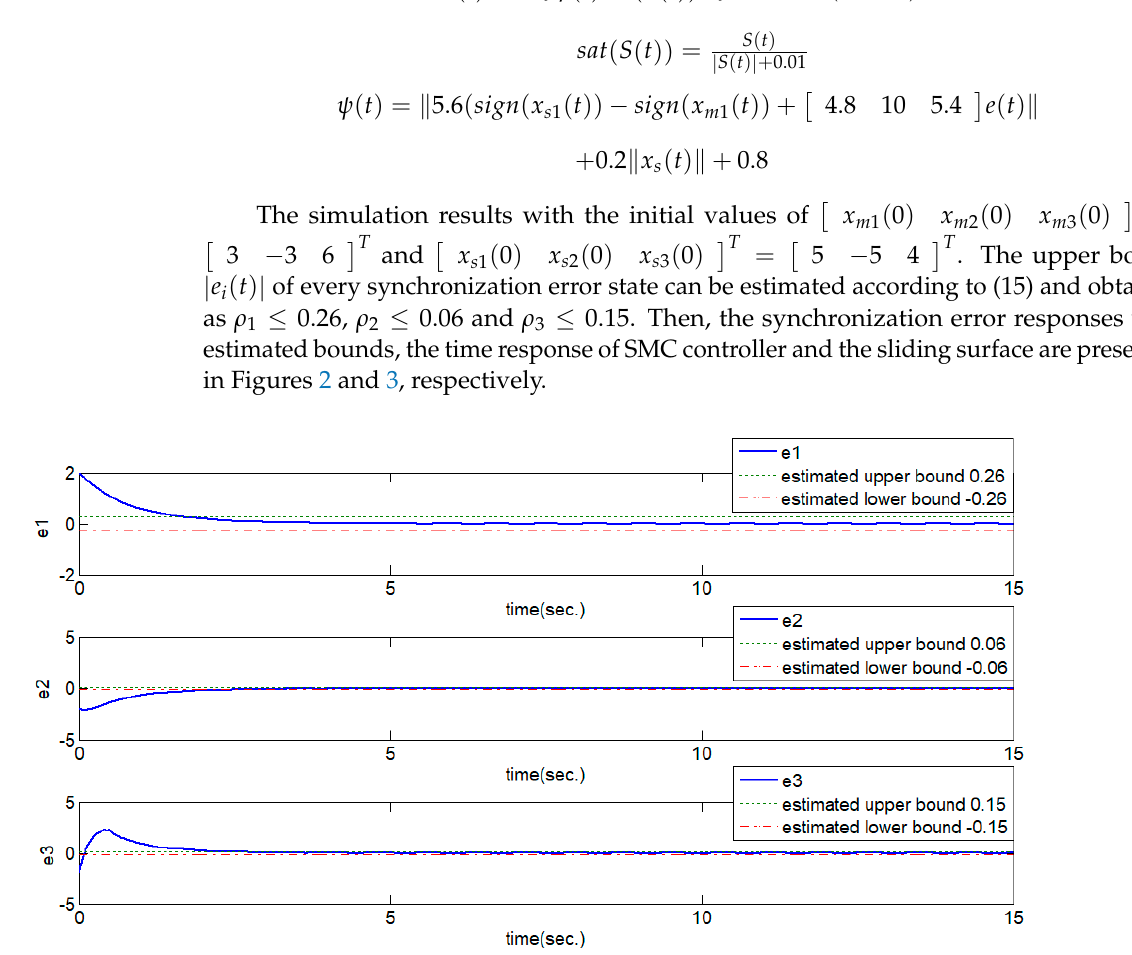
Figure 2. The synchronization error responses with estimated bounds (mismatched condition).